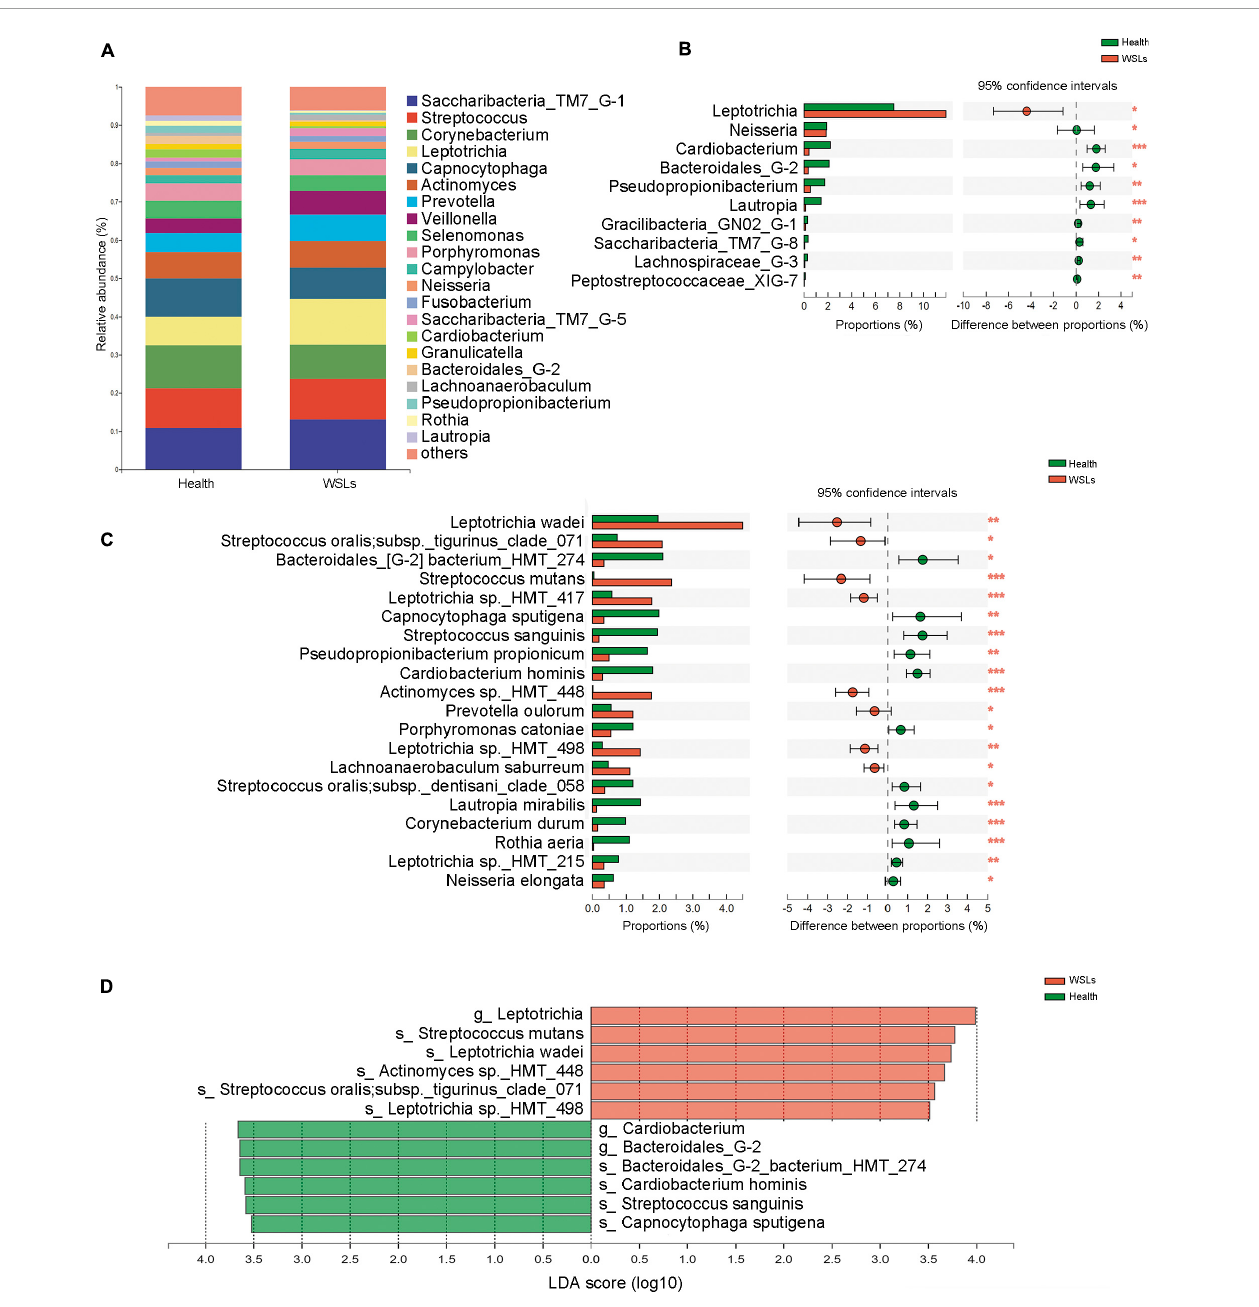
FIGURE2 Comparison of microbial composition between WSLs and health group. (A) Relative abundances of the core genera (relative abundance > 1.0%) in WSLs and health groups. “Others” represented all the genera less than 1%. (B) The most significantly different 10 genera in proportion between WSLs and health group were plotted (ranked by relative abundance). Leptotrichia was dominant in WSLs lesions while the others enriched in health group. (C) The top 20 species showed significant differences between WSLs and health group (ranked by relative abundance). (D) LEfSe analysis was performed between both groups at genus and species levels. Significantly differentiated distributed genera and species were displayed as the LDA score > 3.5 (* P < 0.05, ** P < 0.01, *** P <